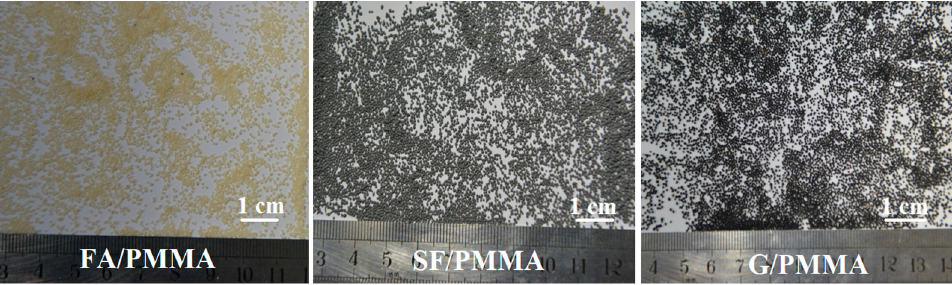
Figure 9. ULDP based on polymer composite beads.